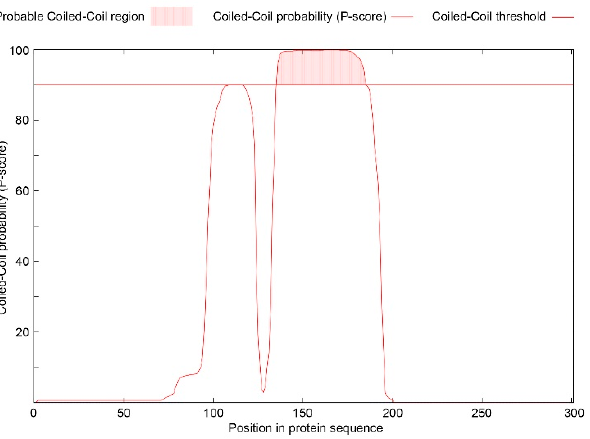
Figure 3. Prediction of coiled-coil segment (above red cut-off line) (https://waggawagga.motorprotein.de/ accessed on 26 May 2022) in the ORF2 protein of Ds-VLRA2.